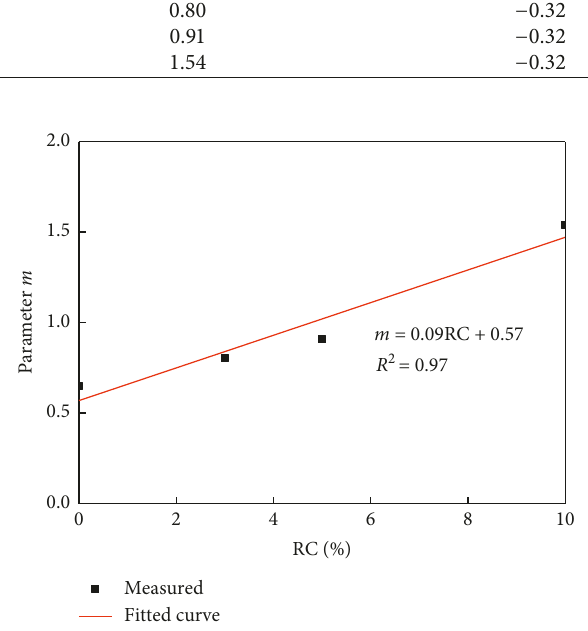
Figure 12: Fitting correlation between the parameter m and the rubber